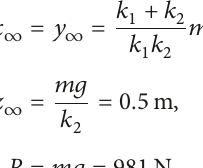
Figure 8: Graphs of mappings expressed via (14) for subsets 𝑆 2 and 𝑆